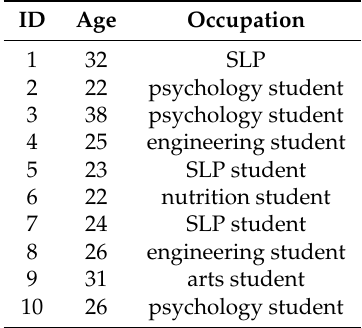
Table 1. Personal information about the participants.